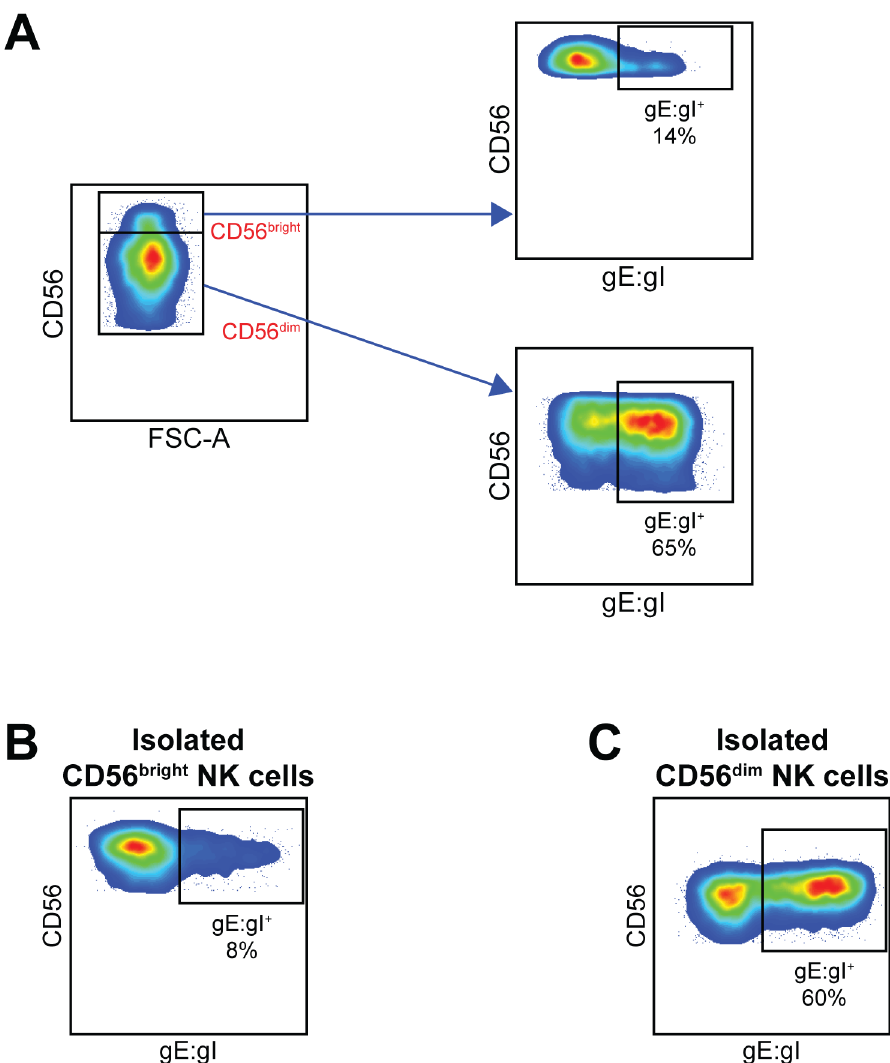
Fig 4. CD56 dim NK cells are more effective than CD56 bright NK cells at supporting VZV infection. (A) Healthy human donor PBMCs were infected with VZV for 2 days then analysed for infection by flow cytometry. Plots show gating strategy for CD56 bright and CD56 dim NK cells (CD3 – CD56 + ) (left panel), with respective surface VZV gE:gI expression (right panels) from one representative donor (n = > 7). (B & C) CD3 – CD56 bright (B) and CD3 – CD56 dim (C) NK cells were isolated from healthy human donor PBMCs by FACS sorting and subsequently infected with VZV for 2 days before analysis by flow cytometry. Plots show surface gE:gI expression from one representative donor (n = 2).